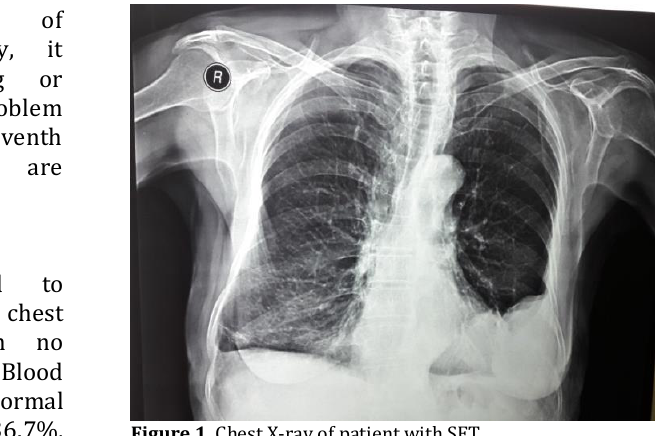
Figure 1. Chest X-ray of patient with